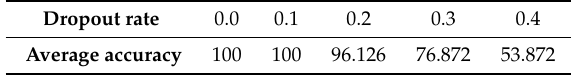
Table 9. Performance comparison of DNN according to the dropout